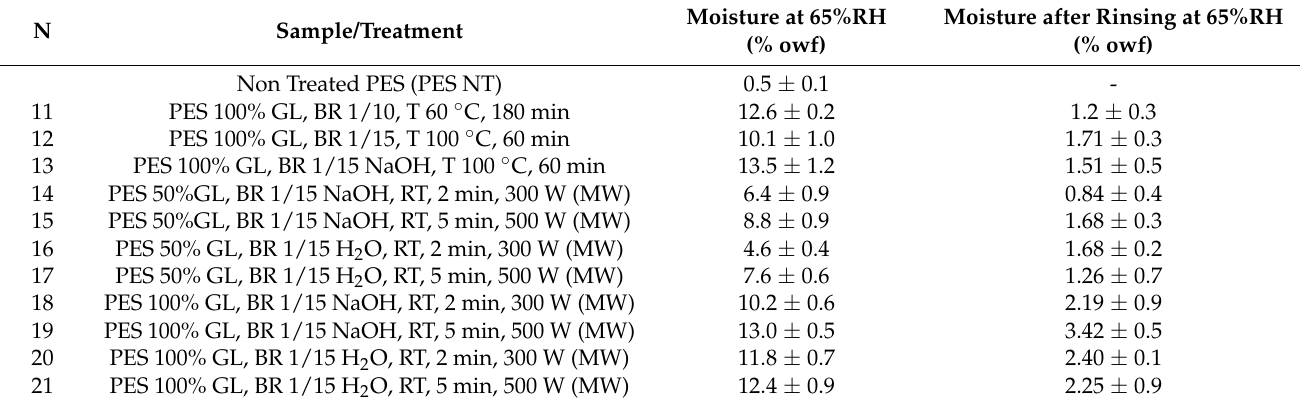
Table 3. Moisture content of the PES/GL treatments before and after rinsing. Bath exhaustion of 100% GL owf at a 1/15 bath ratio at 100 ◦ C, t = 60 min in neutral or alkaline conditions and with microwave irradiation (MW) of the GL solution at different concentrations, power and treatment